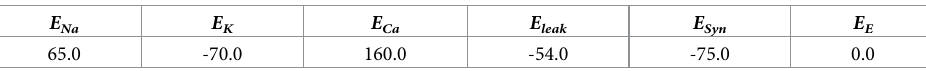
Table 2. Reversal potential parameters and perturbation reversal potential (in